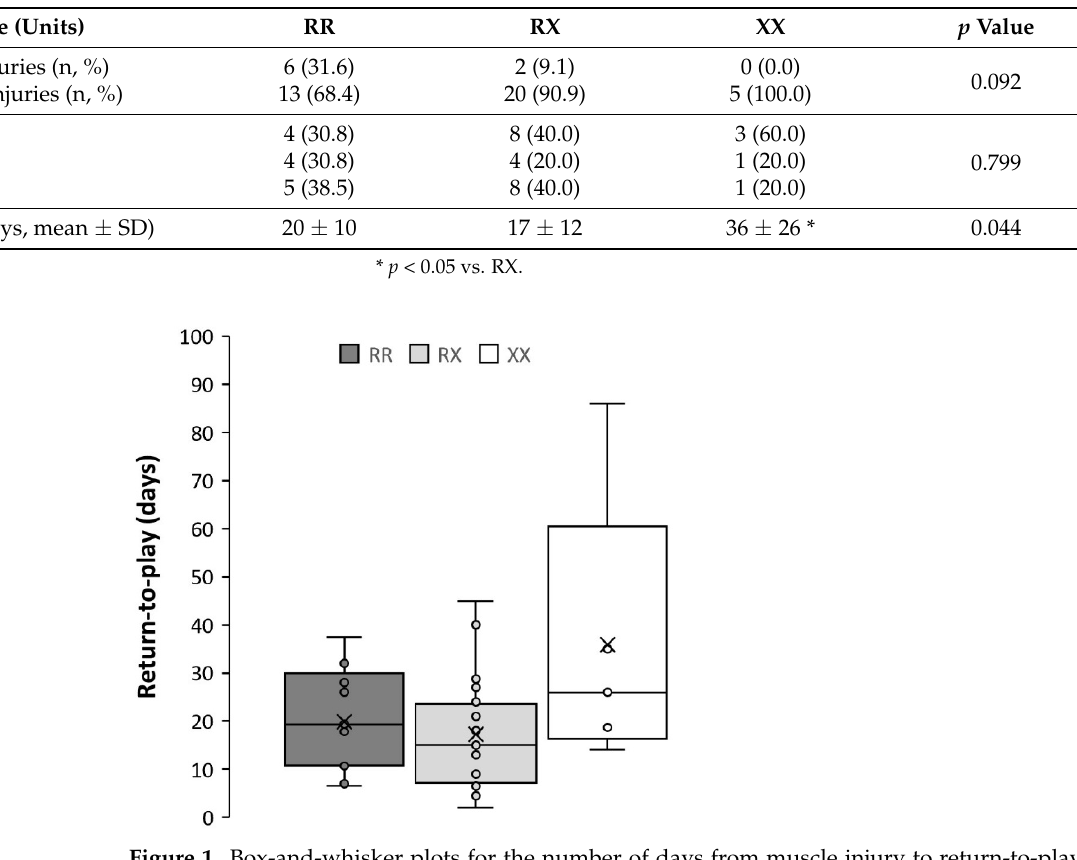
Figure 1. Box-and-whisker plots for the number of days from muscle injury to return-to-play in professional soccer players according to α -actinin-3 ( ACTN3 ) R577X genotype. In each box, the bottom line represents the first quartile, the line within the box is the median and the upper line is the third quartile, and the whiskers are 1.5 × interquartile range.